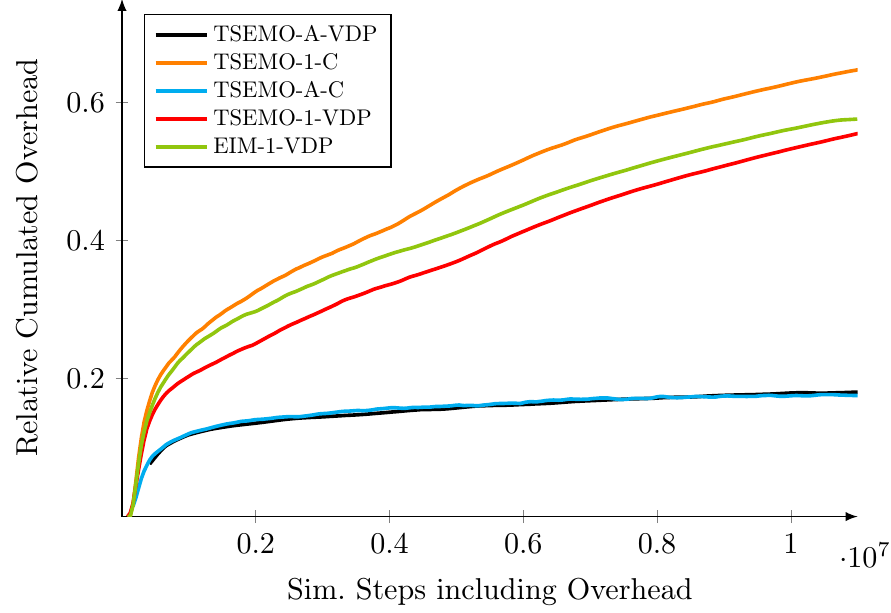
Figure 5. Relative cumulative overhead (c.f. Section 5.2) of the BO variants. The overhead of Rand, NSGA-II and MOPSO are not shown because they are very small <